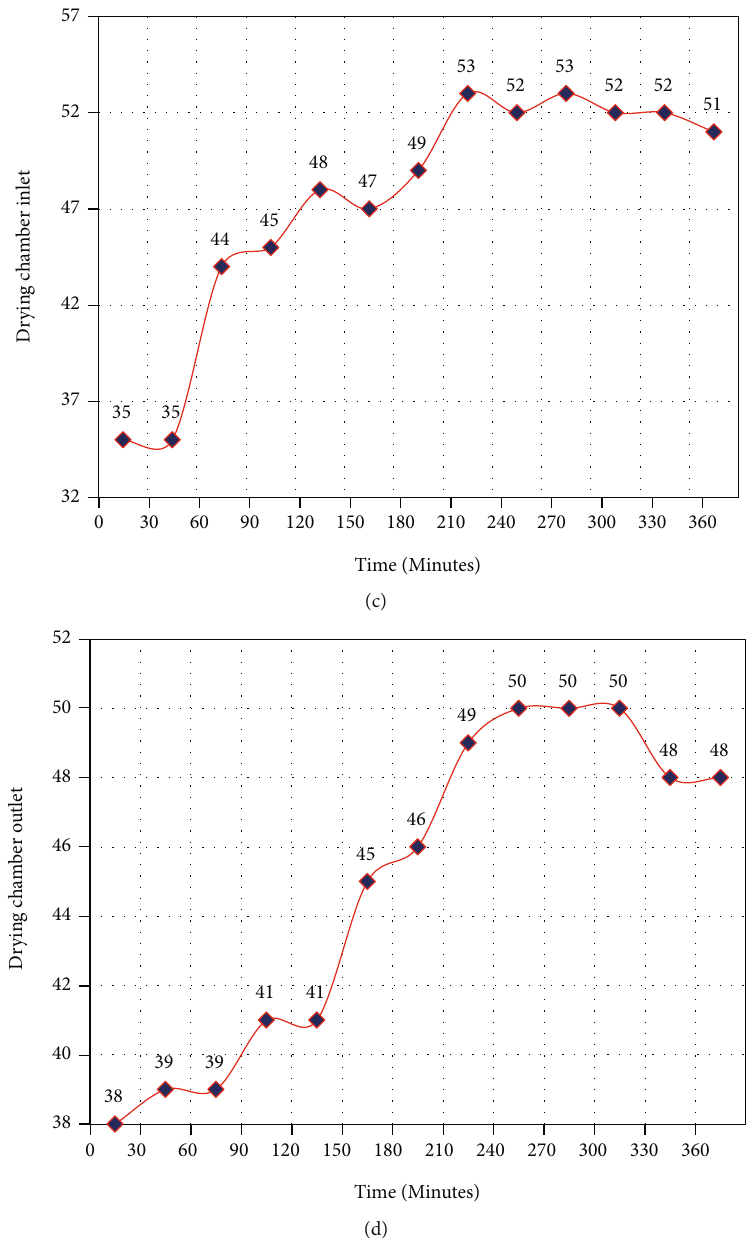
Figure 4: Variation of temperature in drying chamber in natural and forced